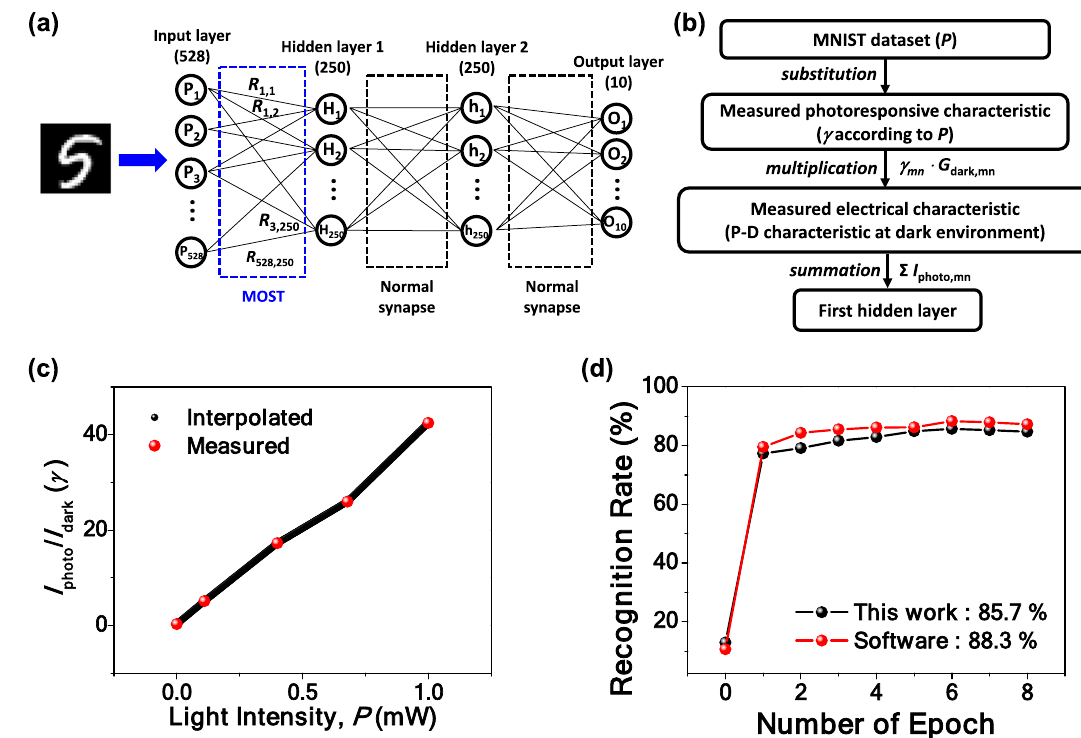
Figure 5. Demonstration of software-based pattern recognition. ( a ) Neural network for recognition of hand-written numbers in the MNIST dataset. Photoresponsive optical characteristics (sensory function) and non-volatile electrical characteristics (mnemonic and synaptic function) measured from the fabricated MOSTs are reflected at the forefront of the network. Measured electrical characteristics are reflected in normal synapses that are connected to the first hidden layer and the second hidden layer, or the second hidden layer and the output layer. ( b ) Software-based simulation sequence to reflect the measured characteristics of the MOST. ( c ) γ ( ≡ I photo / I dark ) as a function of the light intensity ( P ). Linear interpolation from the measured data is utilized to create extra data. ( d ) Simulated recognition accuracy according to the number of training epochs. Recognition rate of 85.7% is achieved, which is close to the upper limit of 88.3% by an ideal software-based